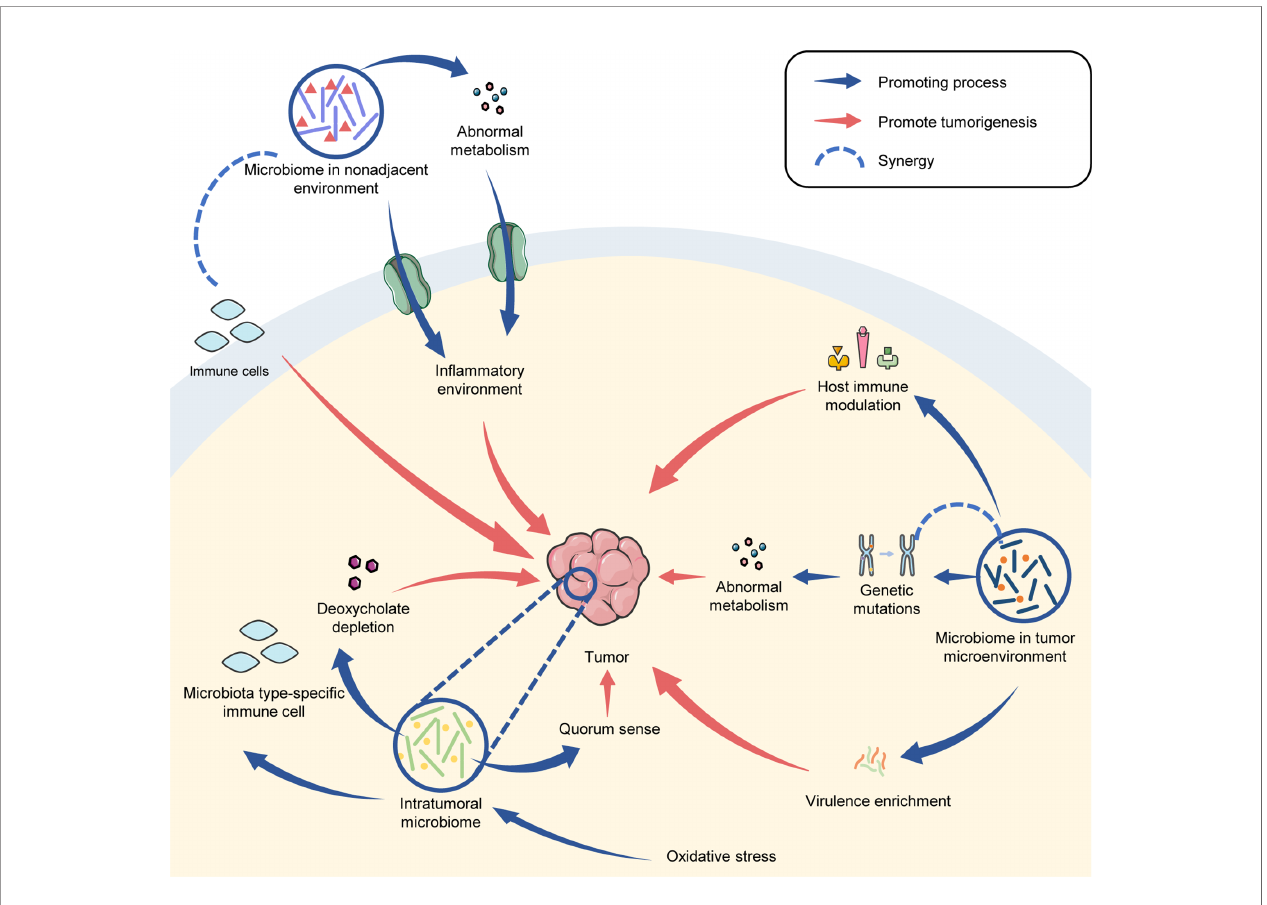
FIGURE 3 | The microbiome drives